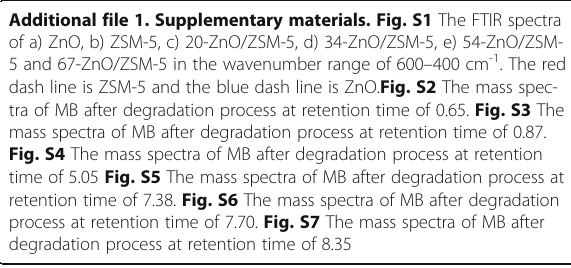
Fig. S4 The mass spectra of MB after degradation process at retention time of 5.05 Fig. S5 The mass spectra of MB after degradation process at retention time of 7.38. Fig. S6 The mass spectra of MB after degradation process at retention time of 7.70. Fig. S7 The mass spectra of MB after degradation process at retention time of 8.35